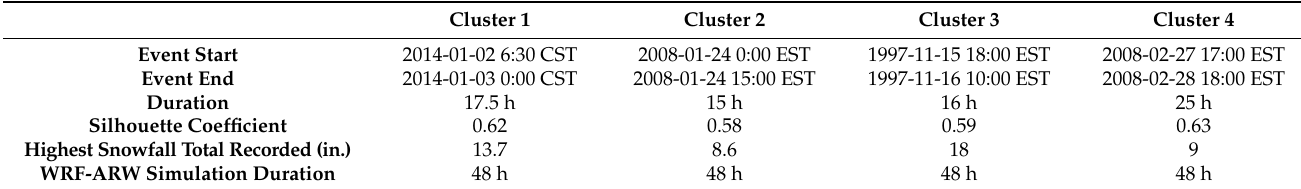
Figure 5. Seasonal distribution of LES cases among different clusters for Lake Michigan ( top ) and Lake Superior ( bottom ). Table 3. Test cases used for WRF-ARW simulations for Lake